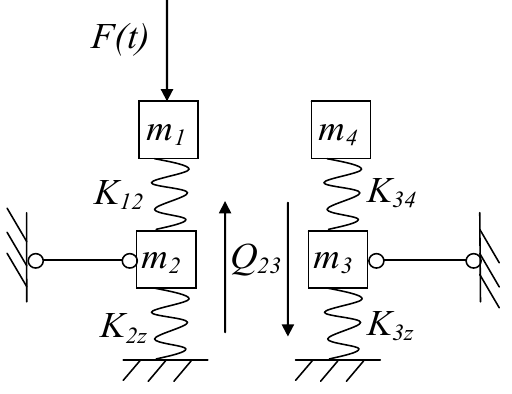
Figure 16. Vertical vibration model.